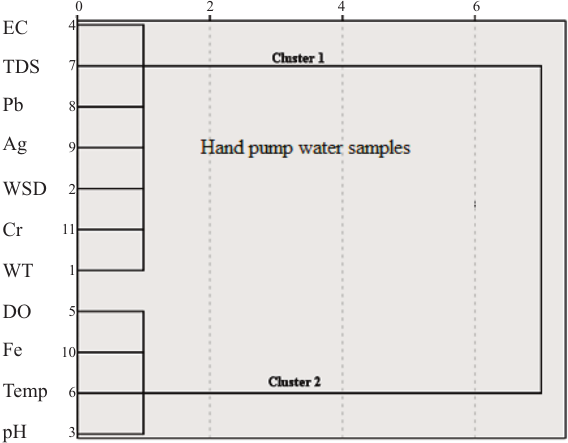
Fig. 4. HCA dendrogram (using Ward Linkage) of HP water parameters.